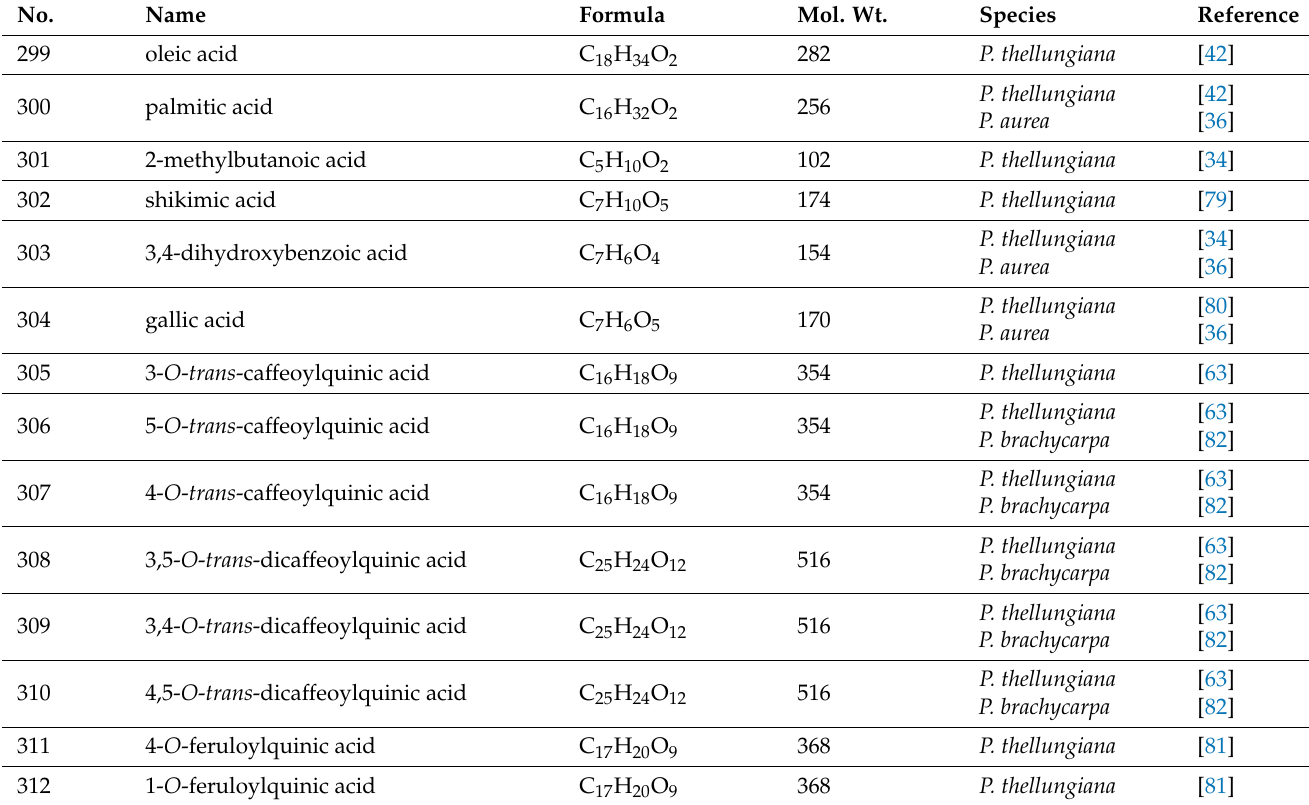
Table 7. Organic acids of Pimpinella